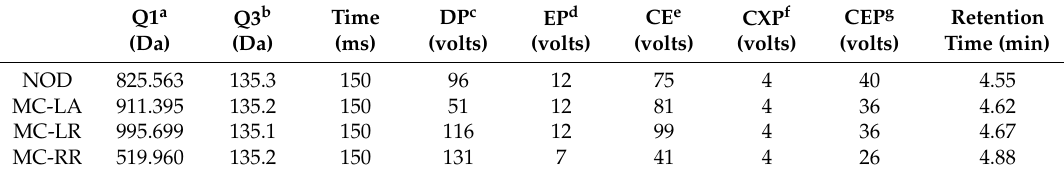
Table 2. Mass spectrometry parameters for the detection of microcystins.